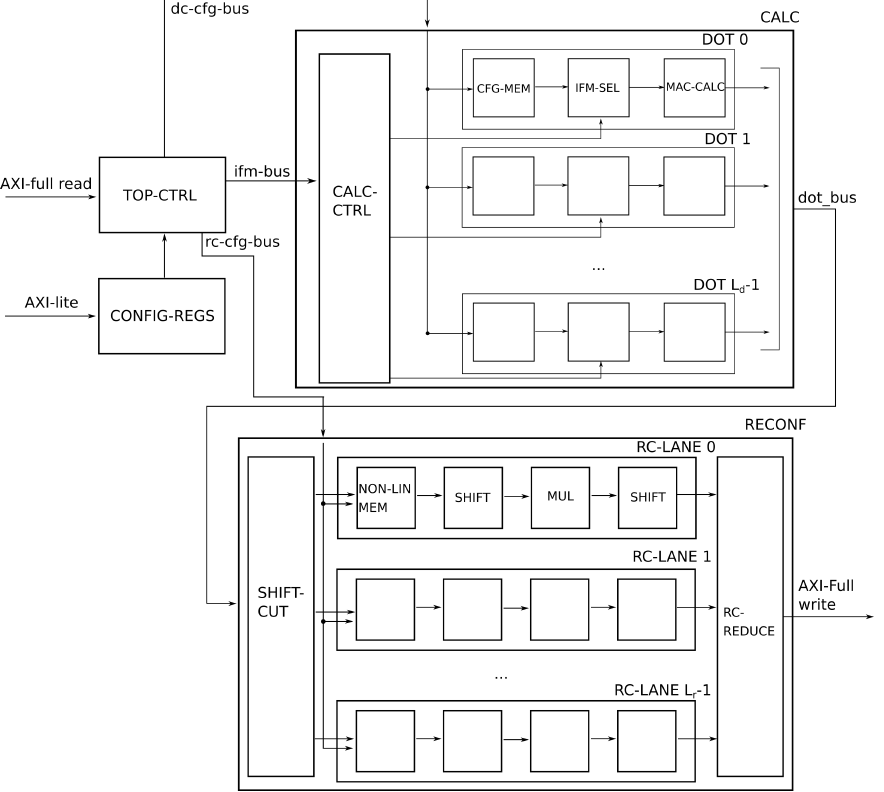
Figure 2. SRMLC top level